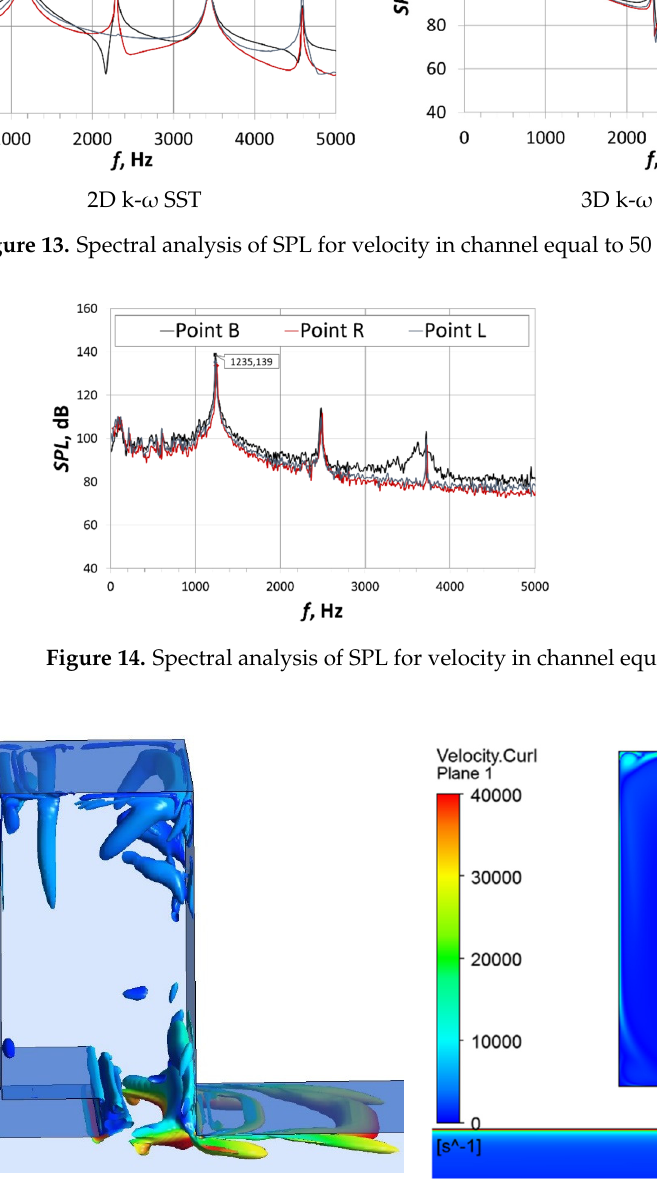
Figure 15. Instantaneous Q-criterion and vorticity distribution for velocity equal to 50 m/s—CFD.